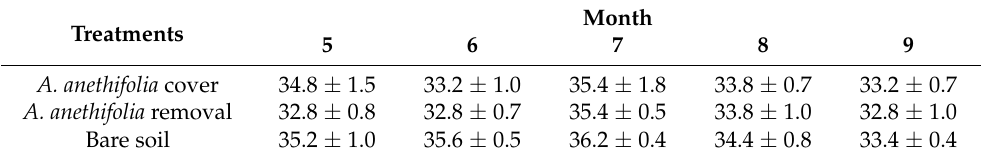
Table 2. Total mercury concentrations (mean ± SD) of the soil (ng · g − 1 ) for the three treatments in 2018.